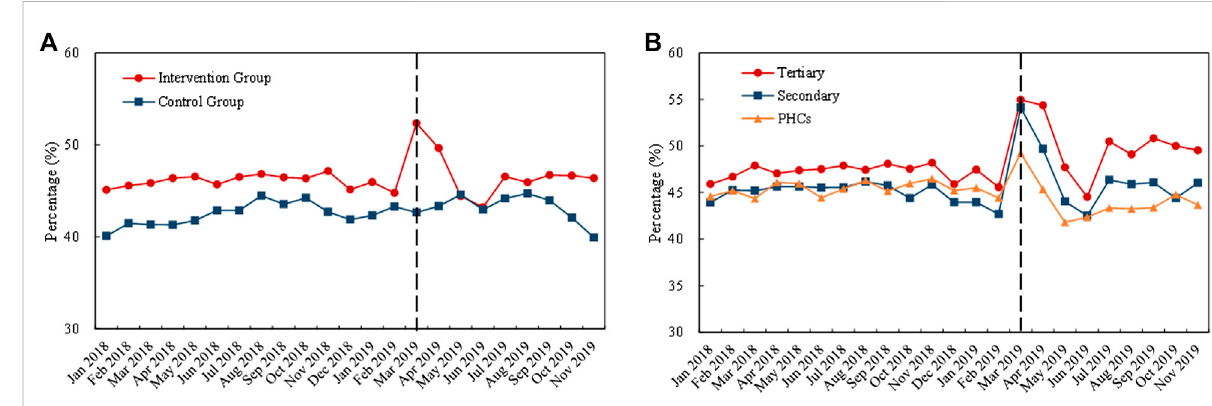
FIGURE 7 Trends in the volume proportion of “ 4 + 7 ” List drugs during January 2018 to November 2019: (A) volume proportion of “ 4 + 7 ” List drugs in the intervention group and control group (B) volume proportion of “ 4 + 7 ” List drugs in intervention group by healthcare setting. Note: PHCs, primary healthcare centers.